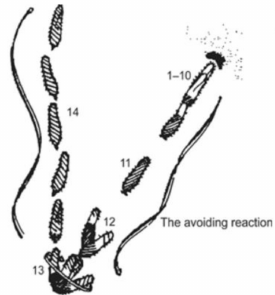
Figure 6. Series of steps in the swimming path of a Paramecium cell that bumps into a solid object (upper right), reverses, pivots in place, and finally swims off in a new direction [44]. A side note on the usefulness of the Paramecium cilia is that the cells can be deciliated and the cilia will regrow on the cell even while impaled on an electrode [42,43]. This procedure allows us to monitor the return of specific channels or sensory proteins using electrophysiology. Therefore, in addition to showing us that the voltage-gated Ca V were exclusively on the cilia, Dunlap [42] was able to show that cilia must regrow more than half of their length before the action potentials return, suggesting that these channels are primarily on the distal end of the